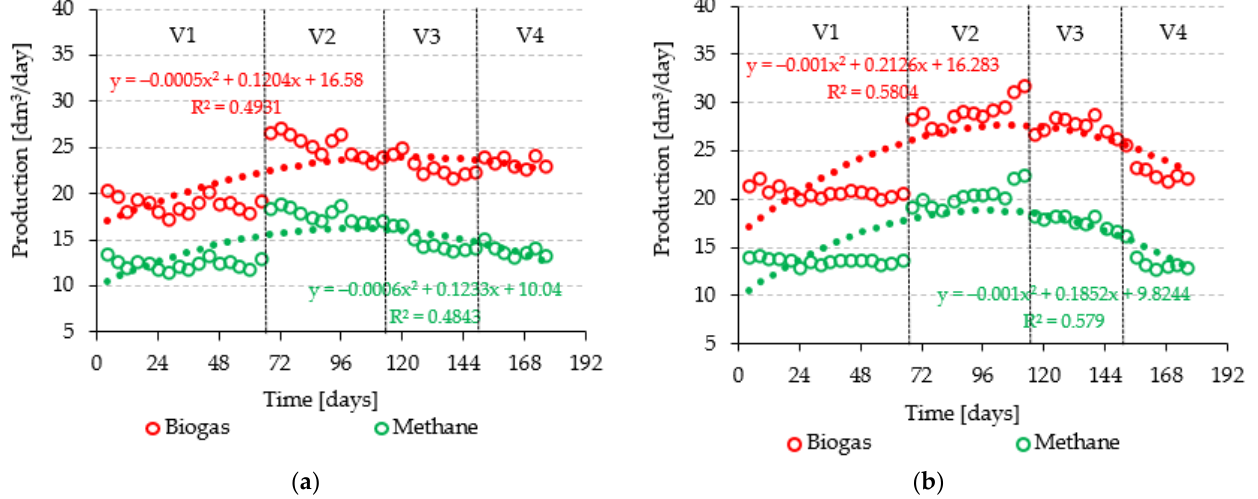
Figure 2. Daily biogas and CH 4 production over time in S1 ( a ) and S2 ( b ).